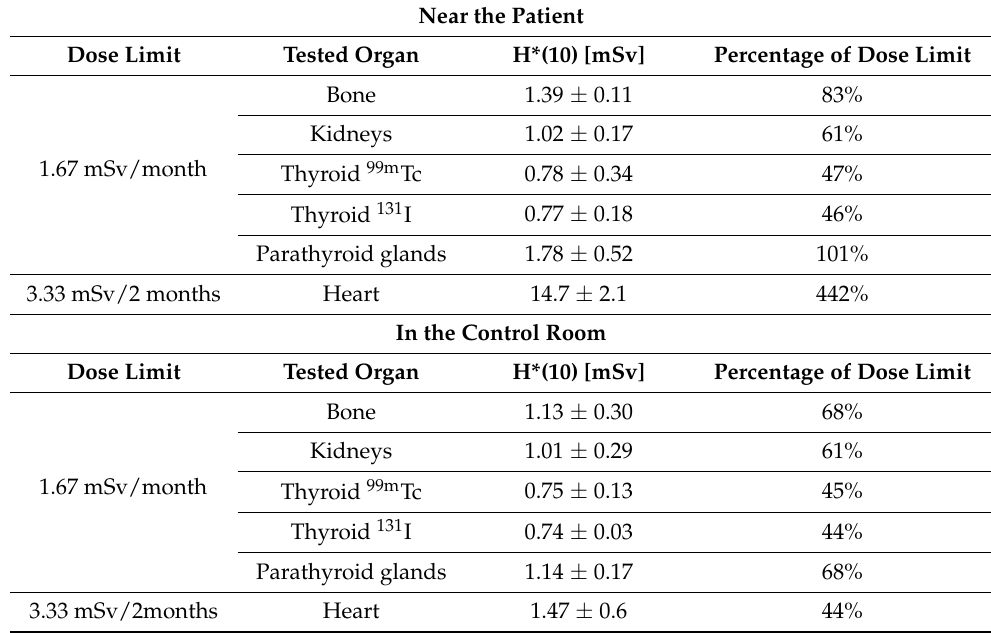
Table 2. Ambient dose equivalent expressed as percentage of the dose limit.